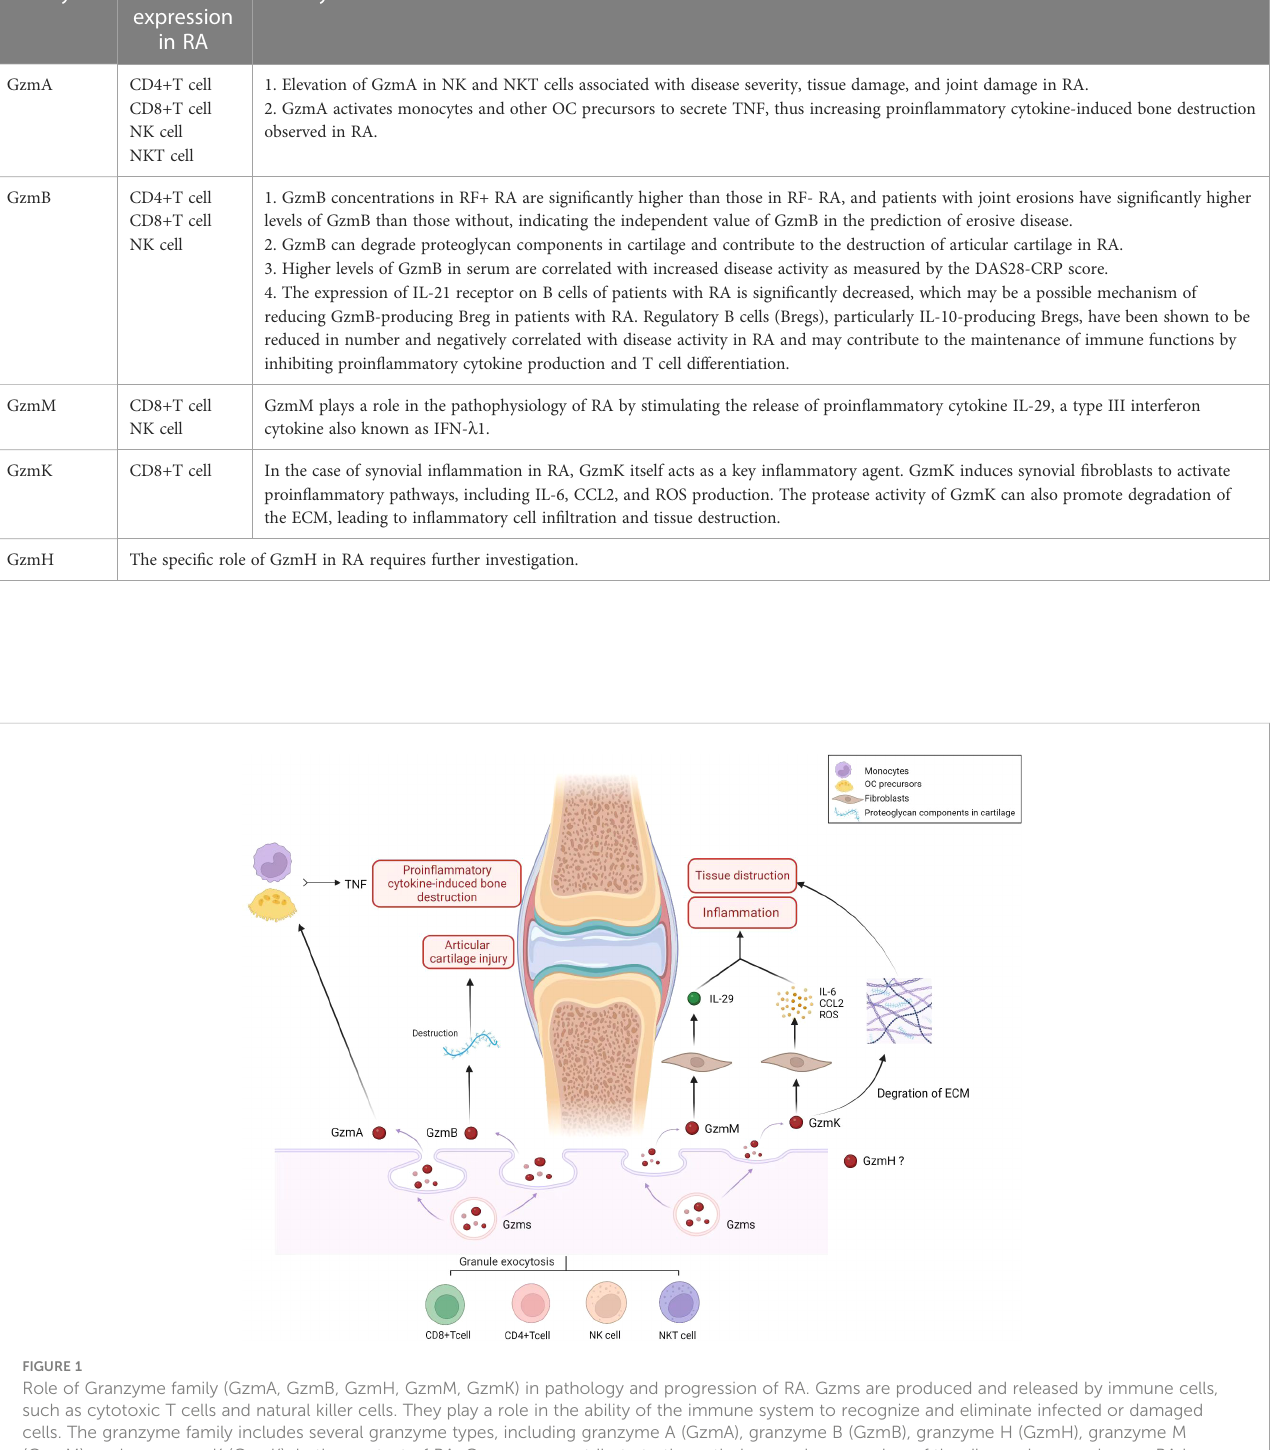
TABLE 1 The physiological function, cellular expression, and potential role of the Gzms family in RA. Granzyme Cellular